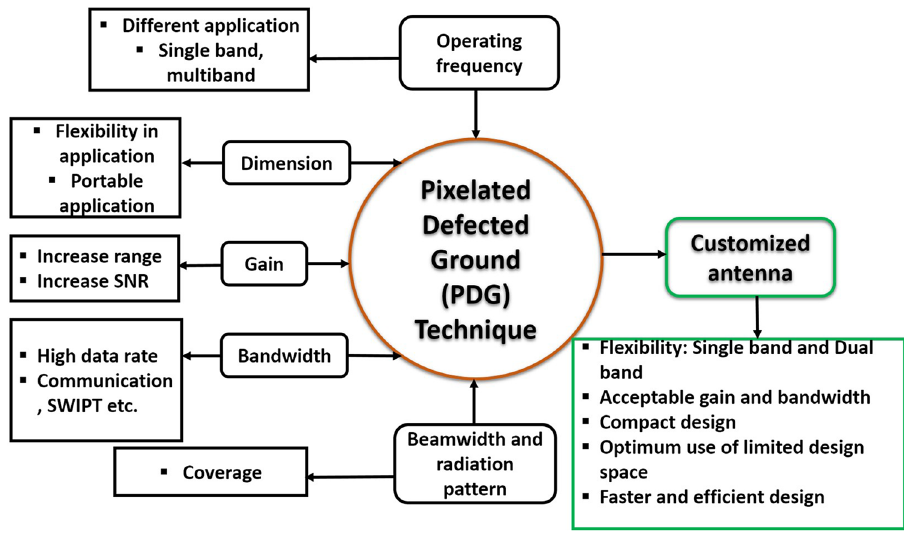
Figure 1. Customised antenna design for IoT application using pixelated DG